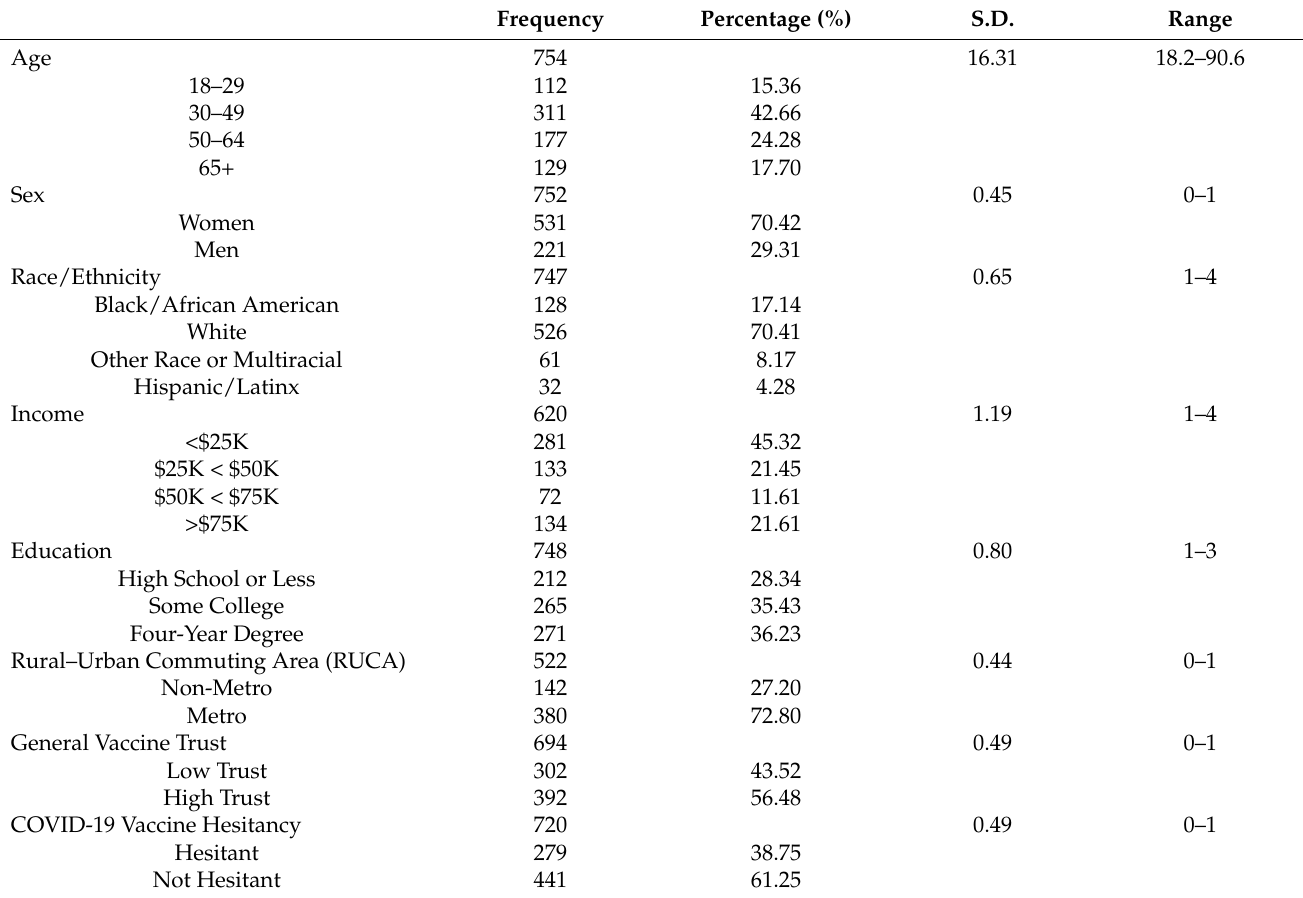
Table 1. Sociodemographics, general vaccine trust, and COVID-19 vaccine